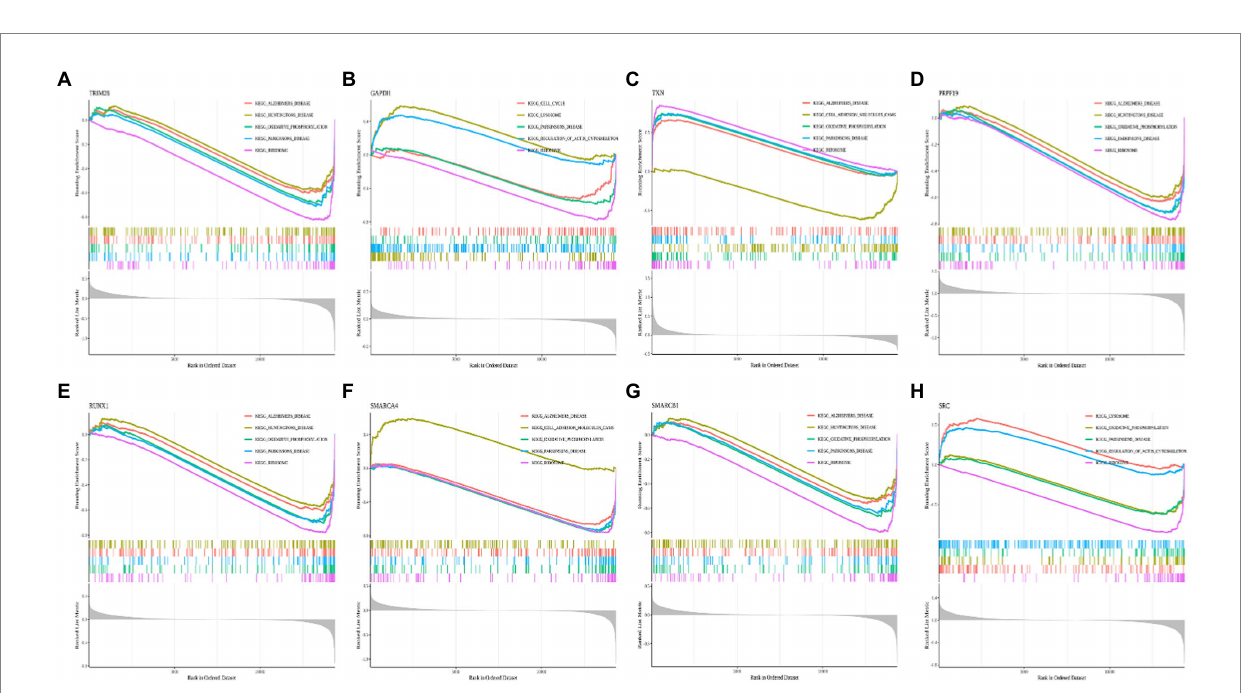
FIGURE 8 Enrichment analysis of pathway and gene ontology (GO) involved hub genes. (A–H) Gene Set Enrichment Analysis (GSEA) of TRIM28, GAPDH, TXN, PRPF19, RUNX1, SMARCA4, SMARCB1 and SRC. Different colors represent different signaling